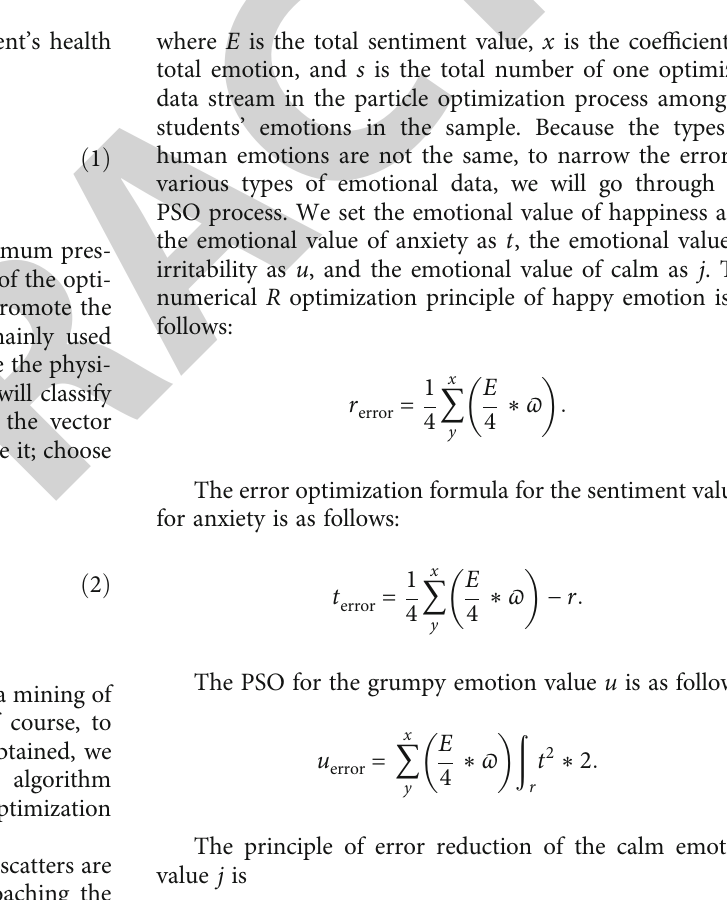
Figure 1: Data mining